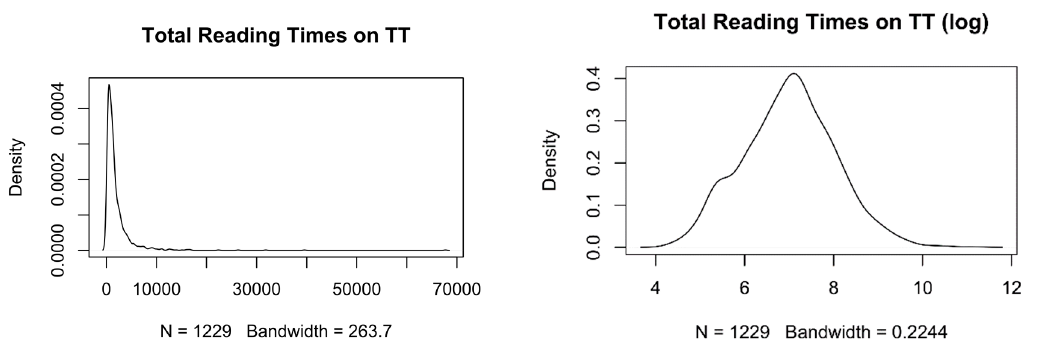
Figure 6. Density ( left ) and log-transformed density ( right ) of total reading times on target text.